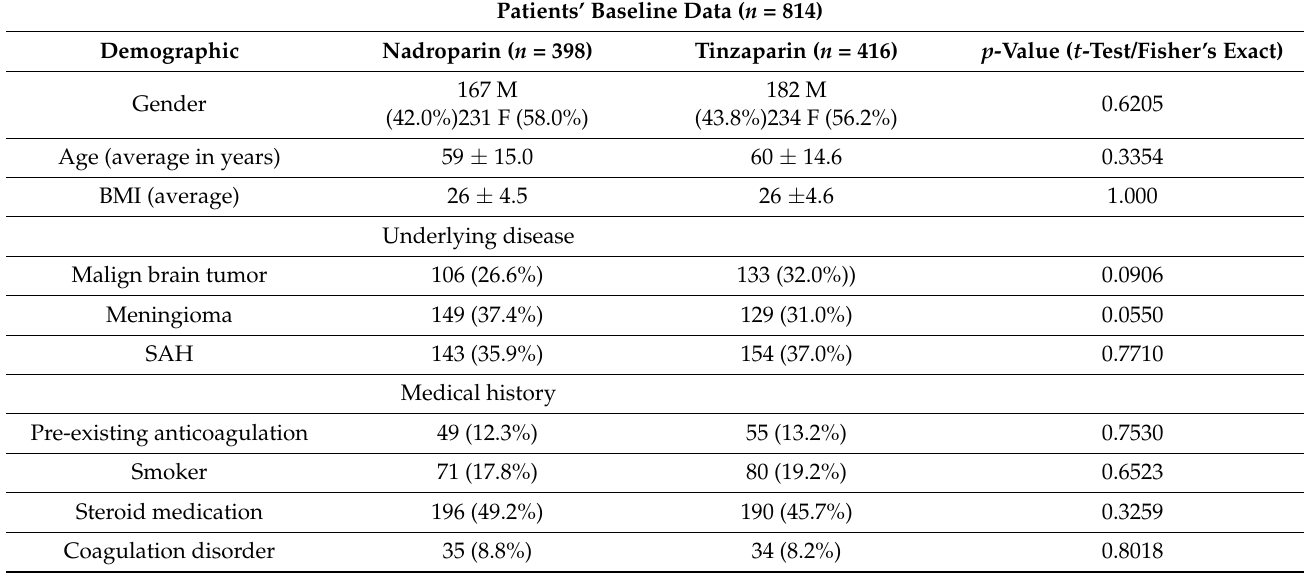
Table 1. Baseline data. Groups are comparable regarding demographic and medical data.